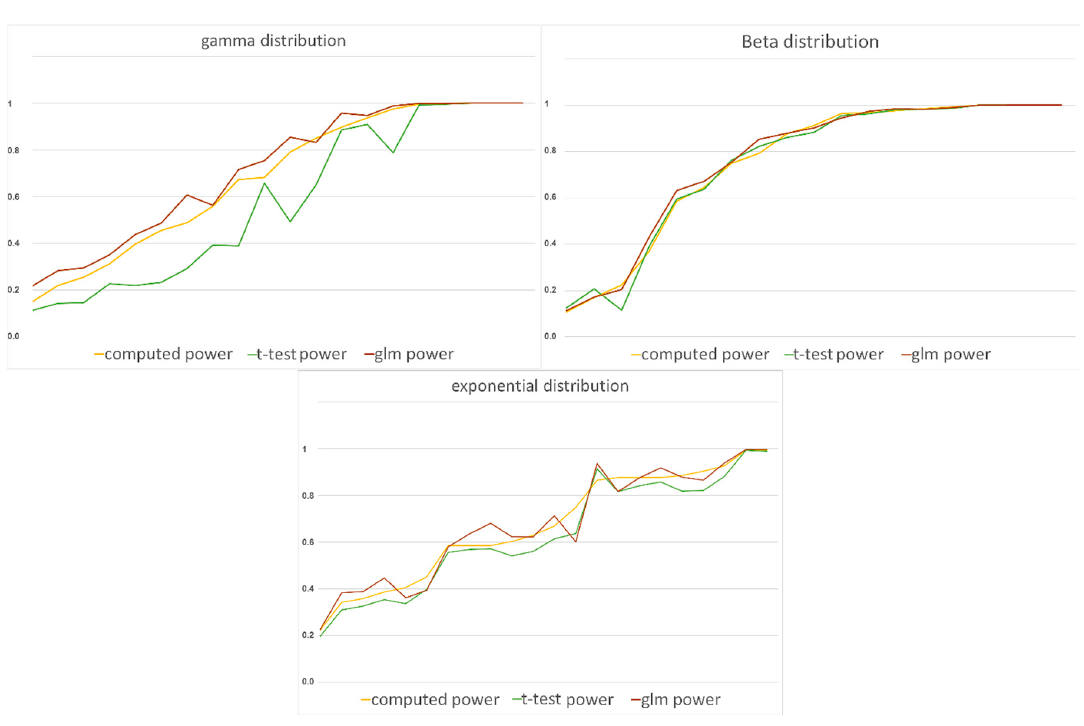
Figure 4. Power rates for the t -test and GLM compared to the computed power rates for the three distributions.